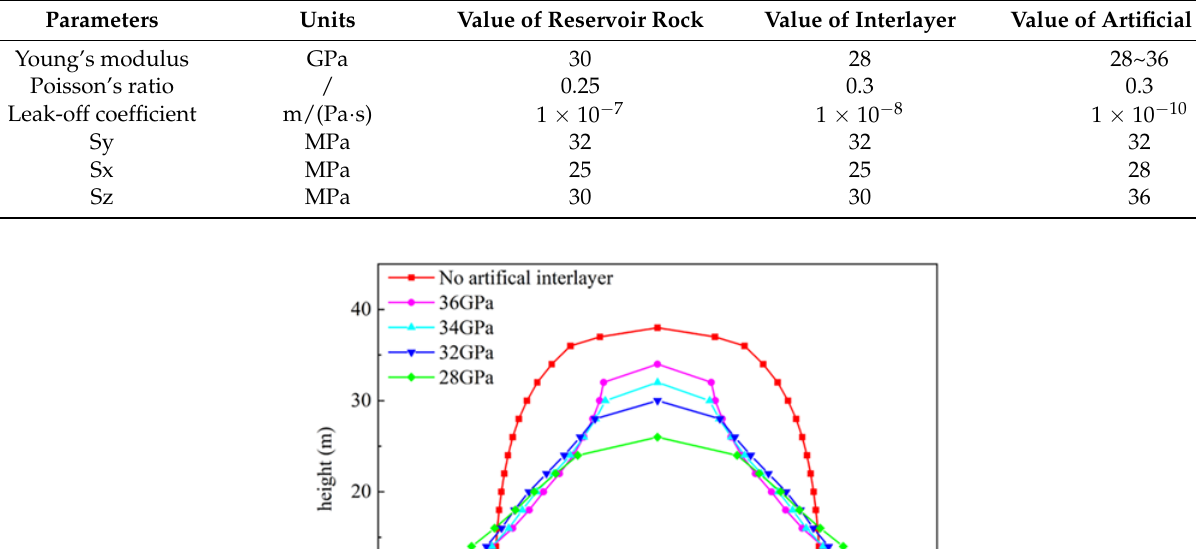
Table 2. The rock mechanics parameters of the stratum.